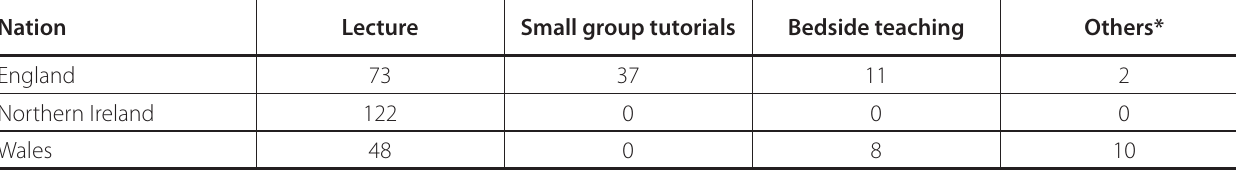
Table 3 . Types of cardiothoracic surgery teaching received at undergraduate